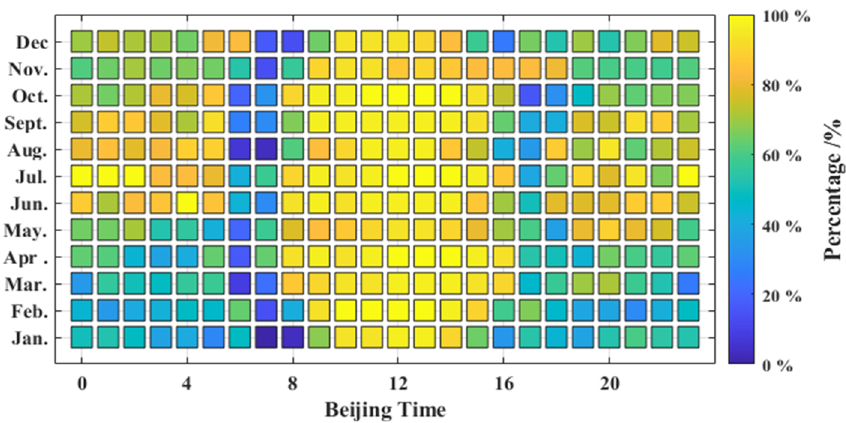
Figure 5. Percentage of the EDH exceeding 10 m in the Taiwan Strait during 2020.